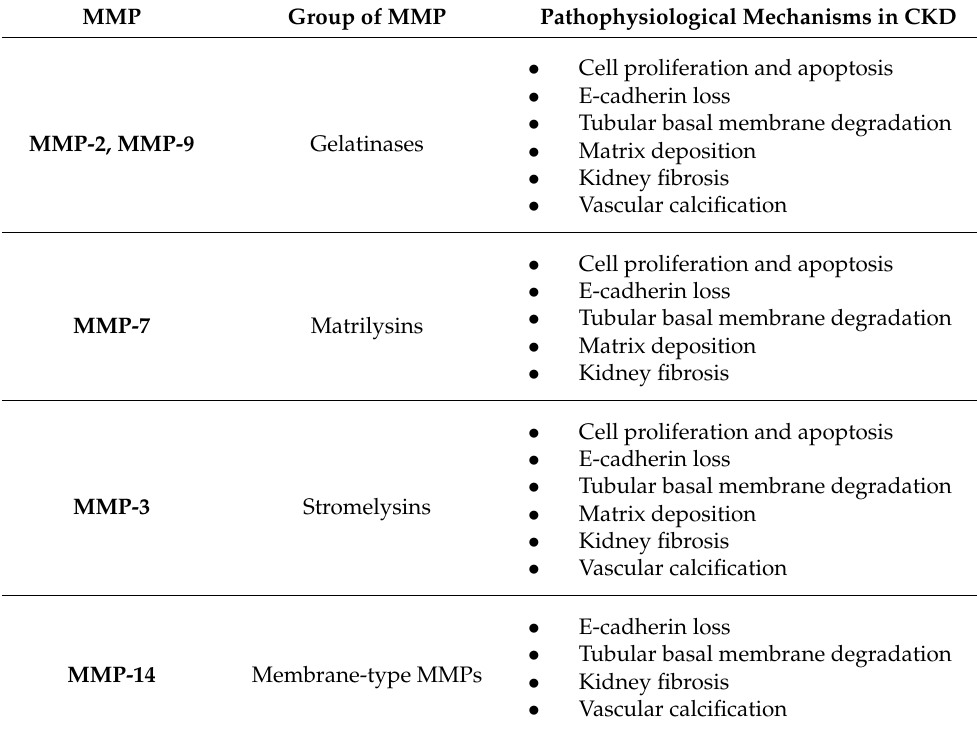
Table 2. Pathophysiological mechanisms in CKD of different MMPs are divided into groups